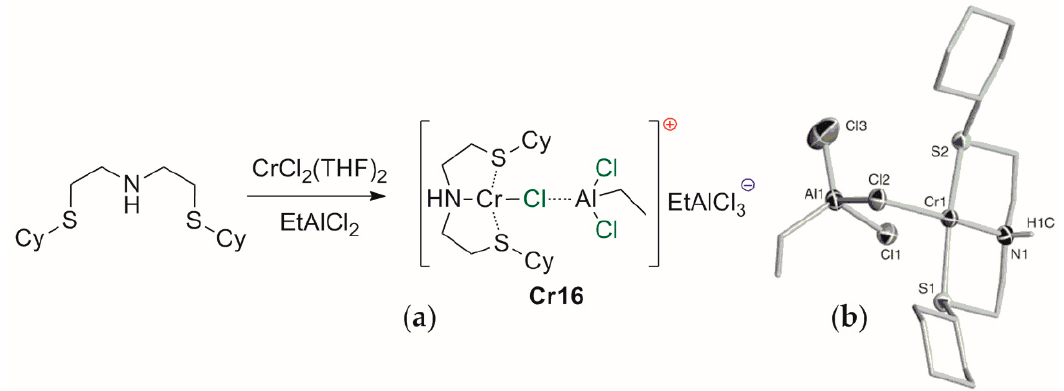
Figure 33. ( a ) Synthesis of complex Cr16 ; ( b ) ORTEP view of Cr16 (thermal ellipsoids set at 30%), with the Al-containing counterion omitted for clarity. Reprinted with permission from [252]. Copyright (2006) Wiley-VCH Verlag GmbH & Co.